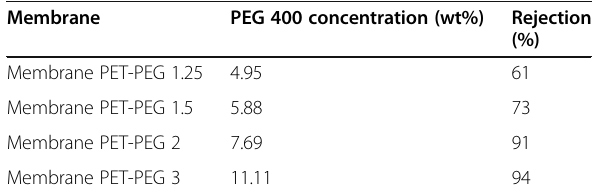
Table 4 Rejection of BSA molecules for PET membranes with different concentrations of PEG 400